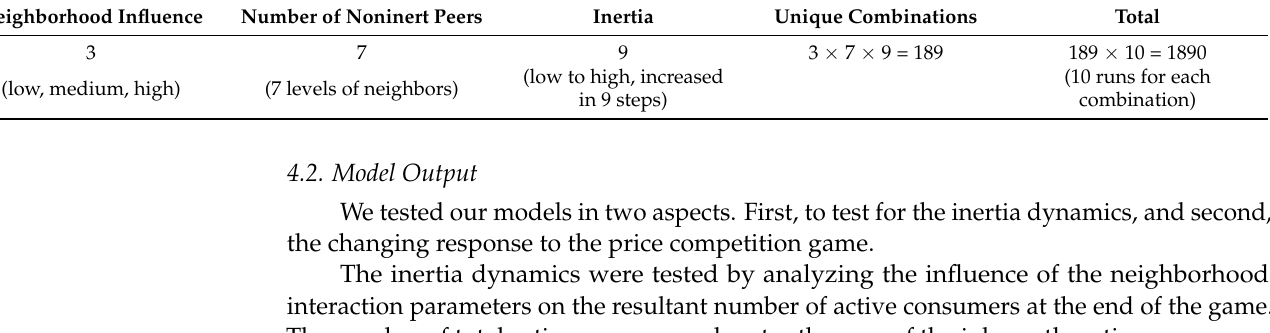
Table 1. ABM experimentation parameters.